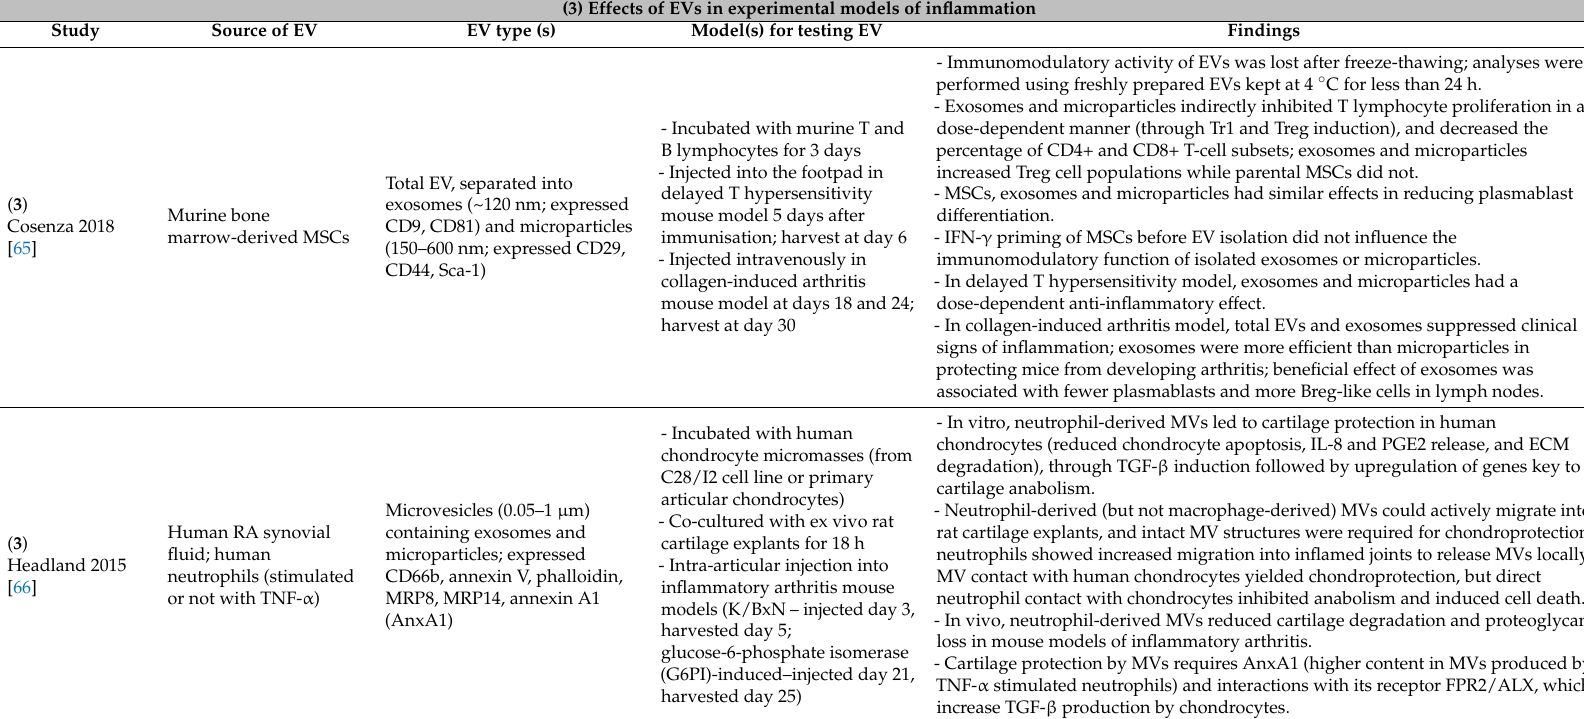
(3) Effects of EVs in experimental models of inflammation